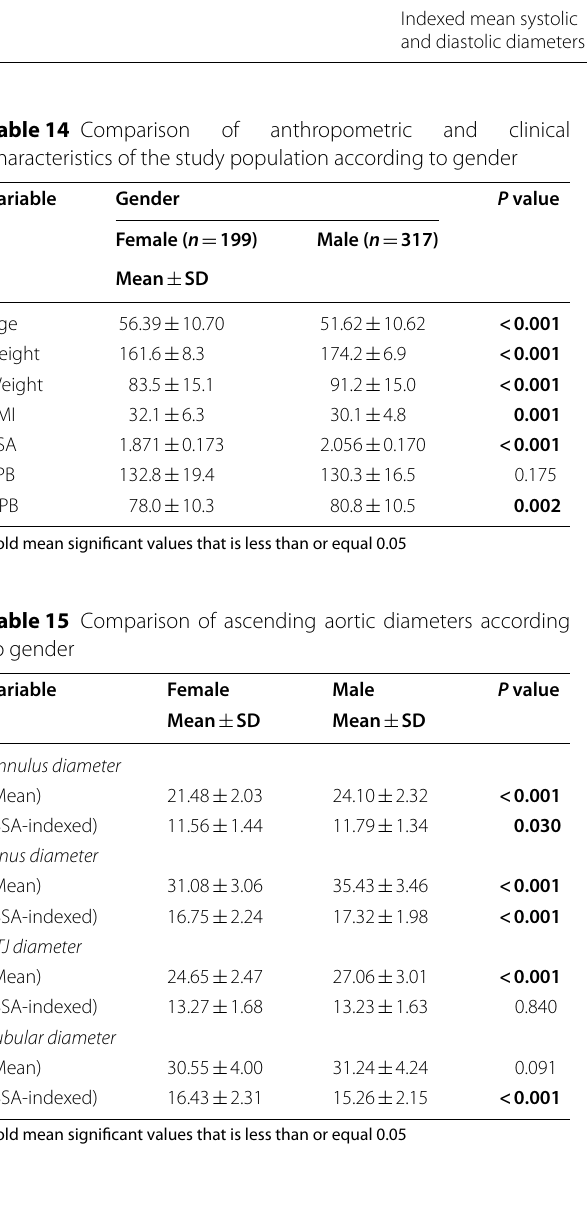
Bold mean significant values that is less than or equal